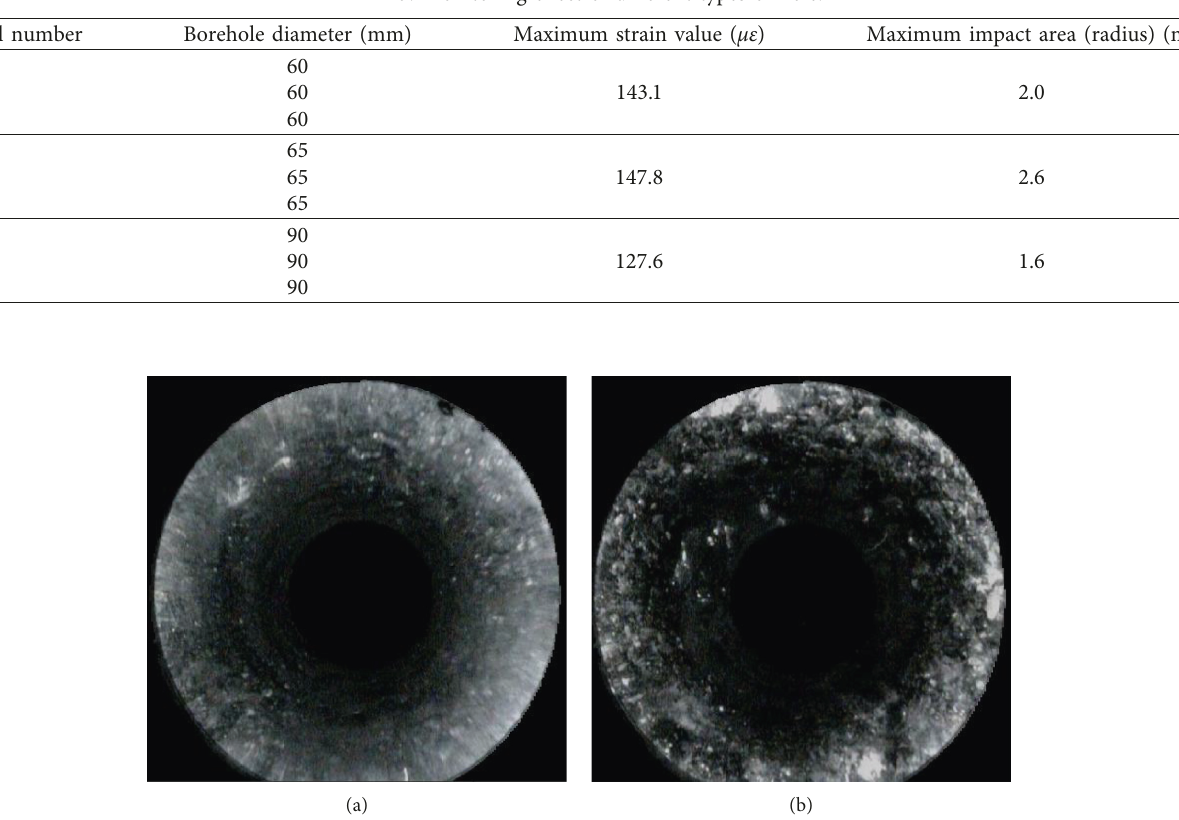
Figure 10: Fiber optic monitoring curve. Table 3: Monitoring effect of different types of hole.